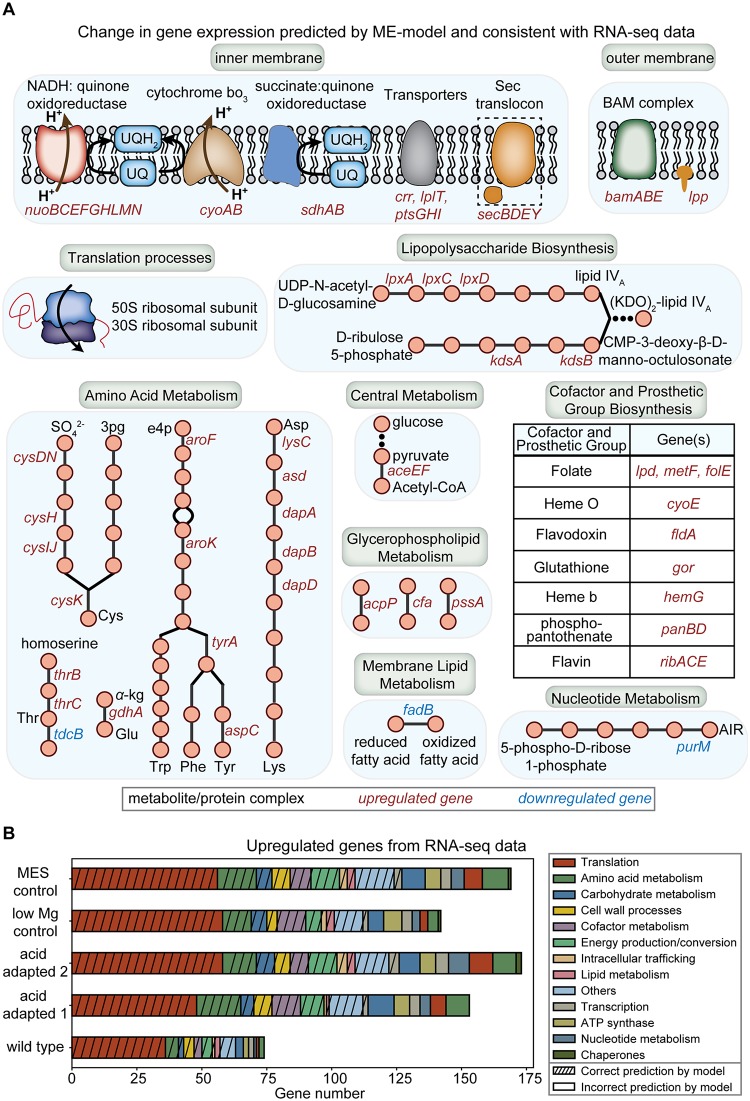
Comparison of ME-model simulations, accounting for the three acid stress mechanisms, against RNA-seq data from E. coli.(A) Differentially expressed genes (DEGs) due to acid stress found to be consistent with model predictions and RNA-seq data. We grouped the list of DEGs found into different COG categories. (B) Upregulated genes in RNA-seq data compared to ME-model simulations. The upregulated genes in RNA-seq data correctly predicted by the ME-model (with strikes in different COG categories) and incorrectly predicted by the ME-model (no strikes in different COG categories) are shown. We listed the five E. coli strains with RNA sequencing data available. The two control strains are labeled as “low Mg control” to account for the effect of lowered magnesium concentration and “MES control” to account for the use of MES buffer during adaptive evolution of E. coli under acid stress.